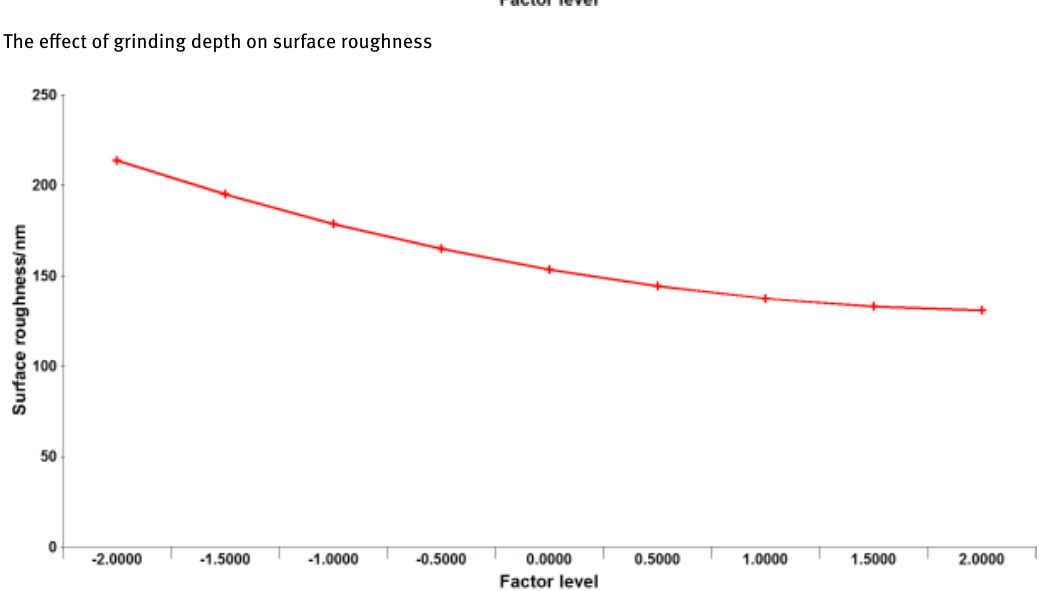
Figure 9: The effect of wheel speed on surface roughness